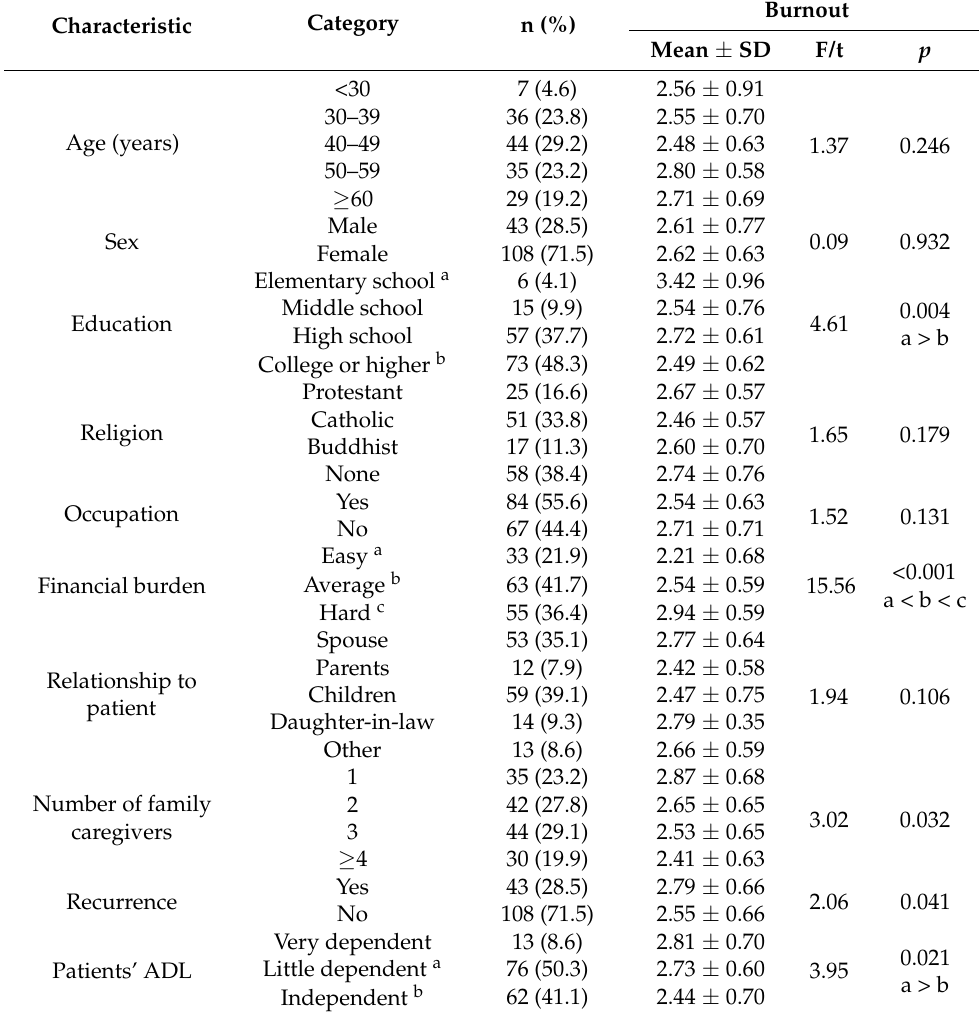
Table 1. Participants’ demographic characteristics and differences in burnout (n = 151).